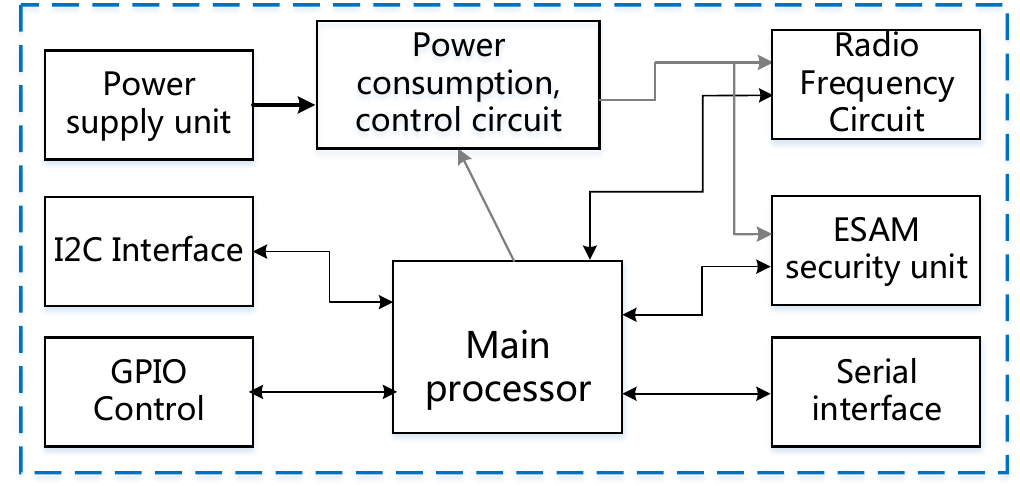
Figure 3. Framework diagram of intelligent fuse hardware